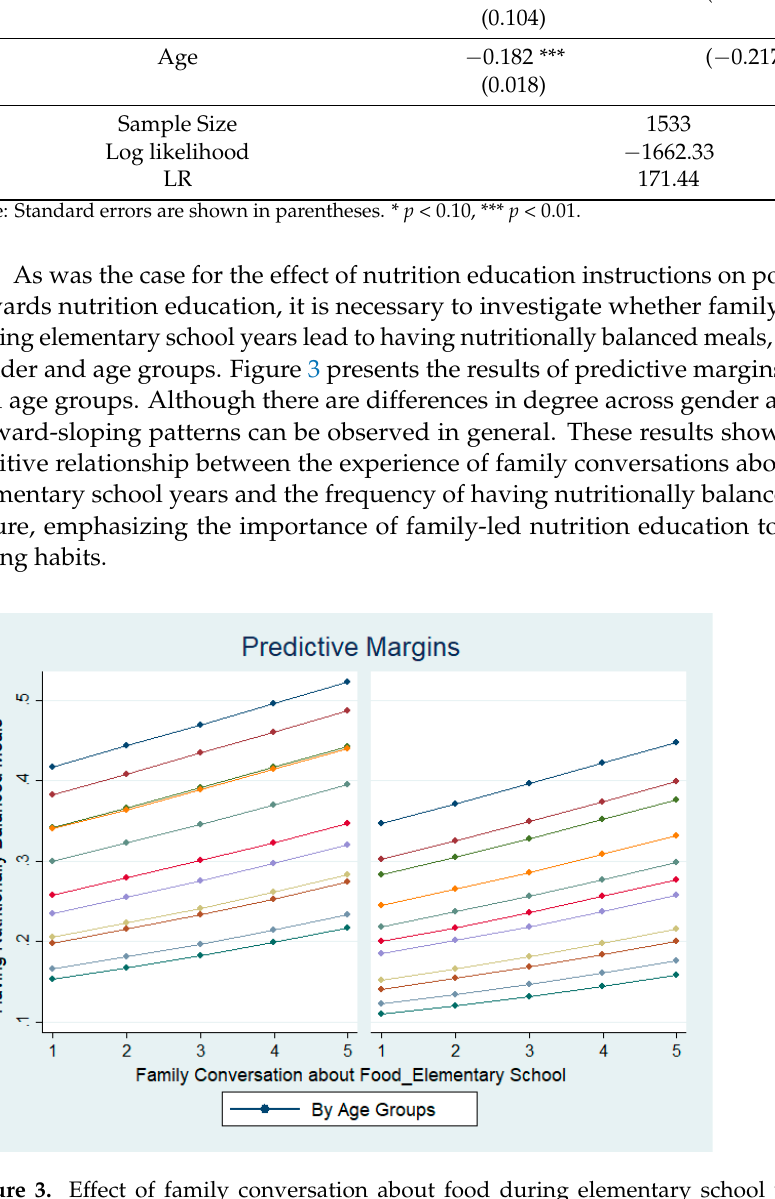
Figure 3. Effect of family conversation about food during elementary school years on having nutritionally balanced meals, by gender and by age groups. Left shows the results of male respondents and right shows the results of female respondents. The 1–5 scales reflect the degree of the respondents’ experiences. 1 = strongly agree, 2 = agree a little, 3 = neither agree nor disagree, 4 = disagree a little, and 5 = strongly disagree.